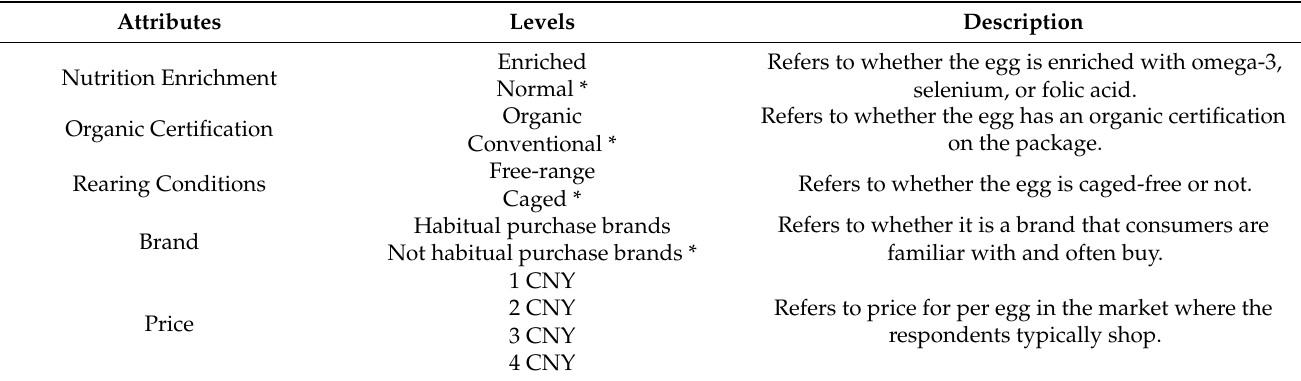
Table 2. Attributes and levels used in the choice experiment